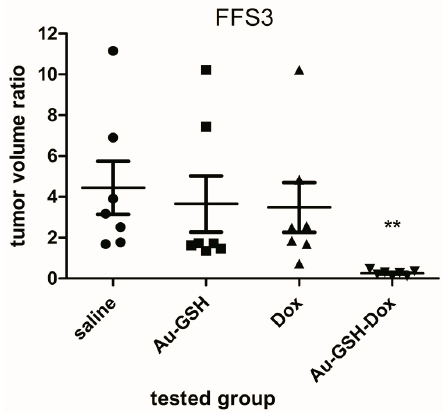
Figure 2. Volume ratio of tumours grown from the FFS3 cell line 72 h after single intratumoural injection of the following compounds: saline ( ● ), Au-GSH ( ■ ), Au-GSH-Dox ( ▼ ), Dox ( ▲ ) compared to the tumour volume before treatment. ** p < 0.01 was assigned as highly significant.